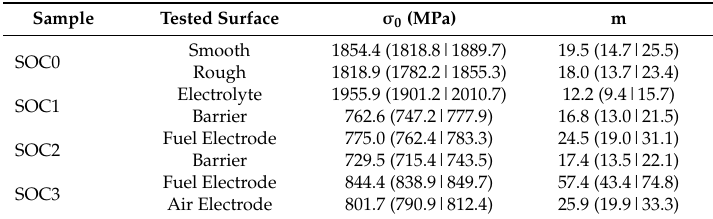
Table 4. Compilation of Weibull parameters obtained from the biaxial bending test, including the 95% confidence intervals.